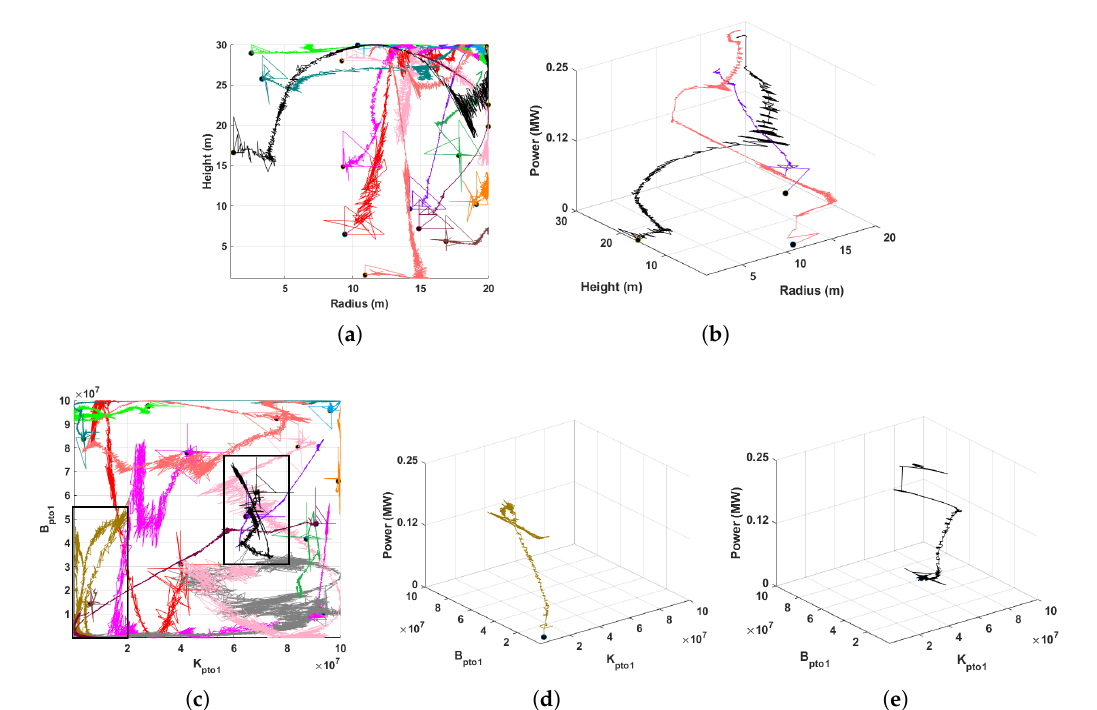
Figure 7. Twenty independent NM runs with the random initial solutions. ( a ) The NM’s trajectory in the cylinder’s dimension (radius and height) optimisation, ( b ) 3D NM’s trajectory in the cylinder’s dimension and the absorbed power. ( c ) NM’s trajectory in the initial value of the damping ( B pto ) and spring ( K pso ) array. ( d , e ) two examples of 3D NM’s trajectory in B pto and K pso